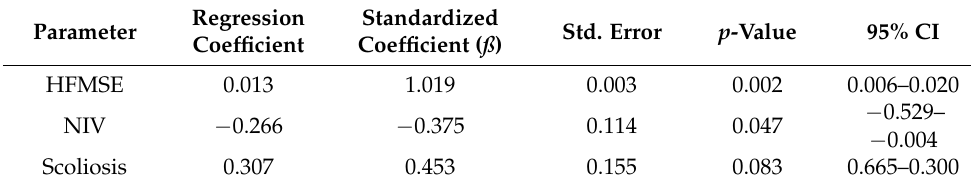
Table 2. Influencing factors on HRQoL in SMA patients during nusinersen-loading period. The EQ-5D-5L index value was the dependent variable in the multiple linear regression analysis with backward stepwise selection. The HFMSE was used as covariate. Abbreviations: CI = confidence interval, HFMSE = Hammersmith Functional Motor Scale Expanded, NIV = non-invasive